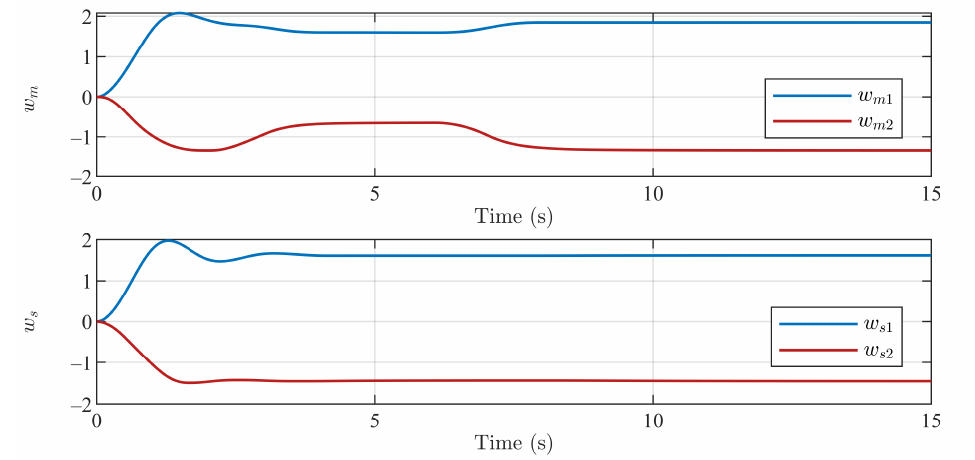
Figure 9. The adaptive parameters of ˆ ω m and ˆ ω s .